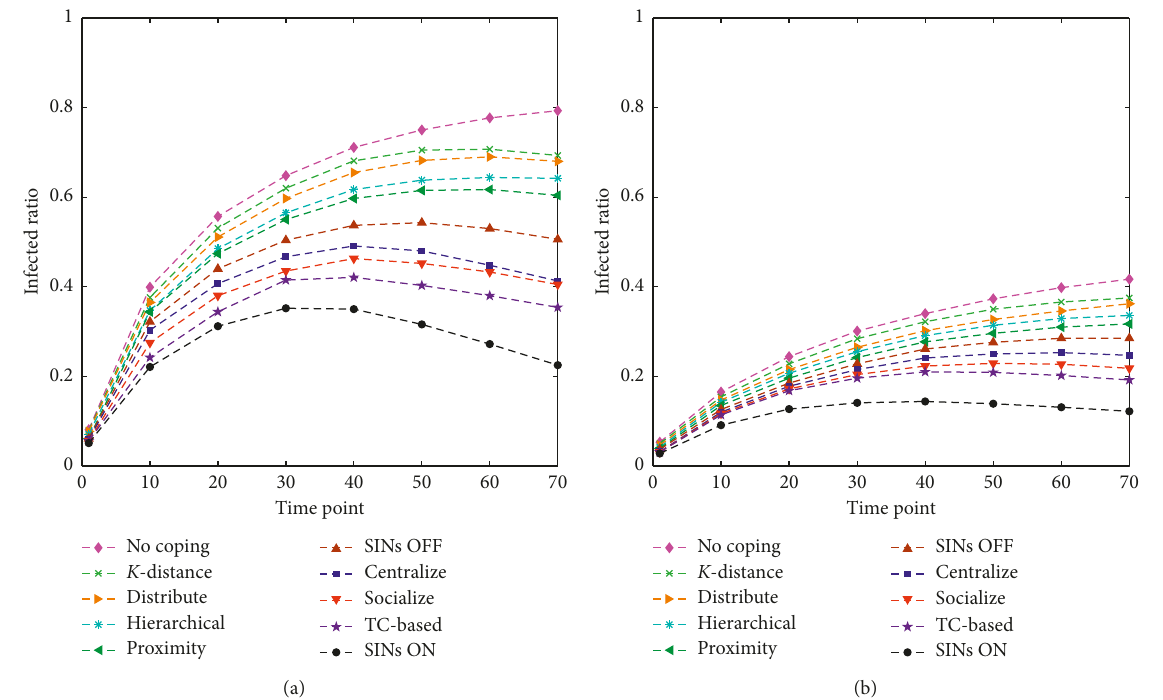
Figure 8: Performance comparison of short-range coping schemes on Haggle (a) and MIT Reality